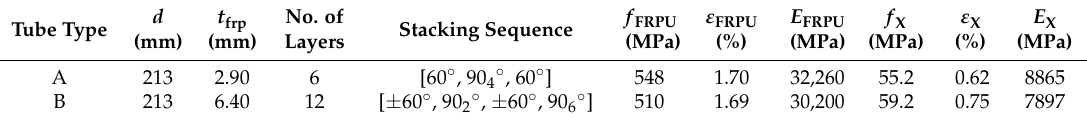
Figure 6. Test setup and stress-hoop strain behavior of the FRP tubes for split-disk test of Tube B [28]. Table 4. Dimension and mechanical properties of FRP tubes.